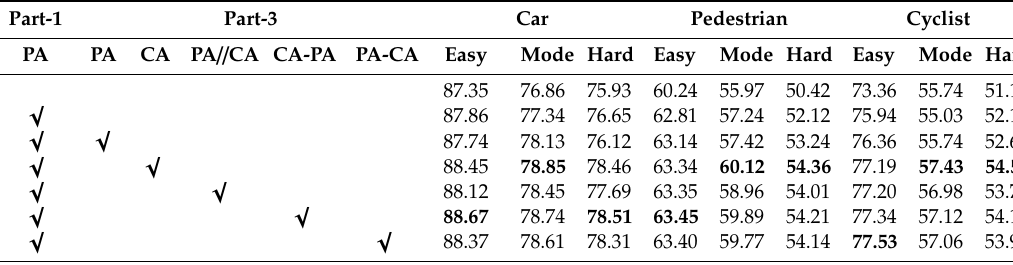
Table 6. 3D object detection performances of detectors embedding different attention modules/ combinations in part-1 and part-3: Average Precision (AP 3D in %) of 3D boxes on KITTI’s val set. We use a 3D IoU threshold of 0.7 for the car class and 0.5 for the pedestrian and cyclist classes. The method in the fourth row is KDA3D’s final choice.